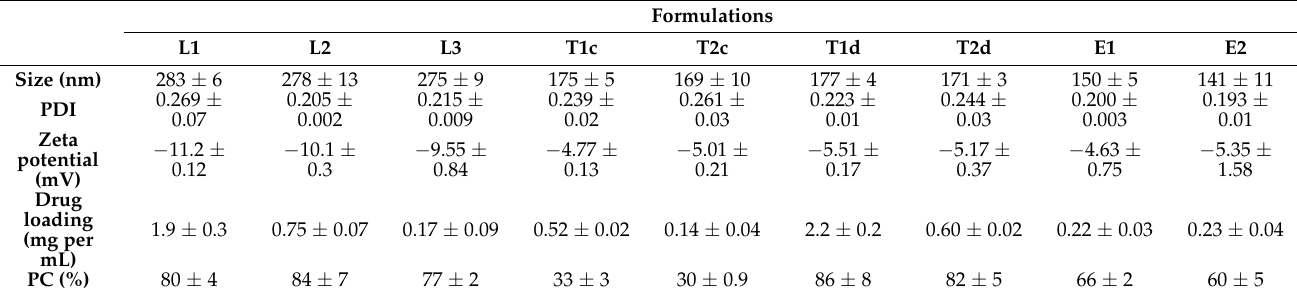
Table 2. Characterization of the B12 lipid vesicles in terms of size, polydispersity index (PDI), zeta-potential, drug loading, and phospholipid content (PC). All results are expressed as mean ± SD ( n =